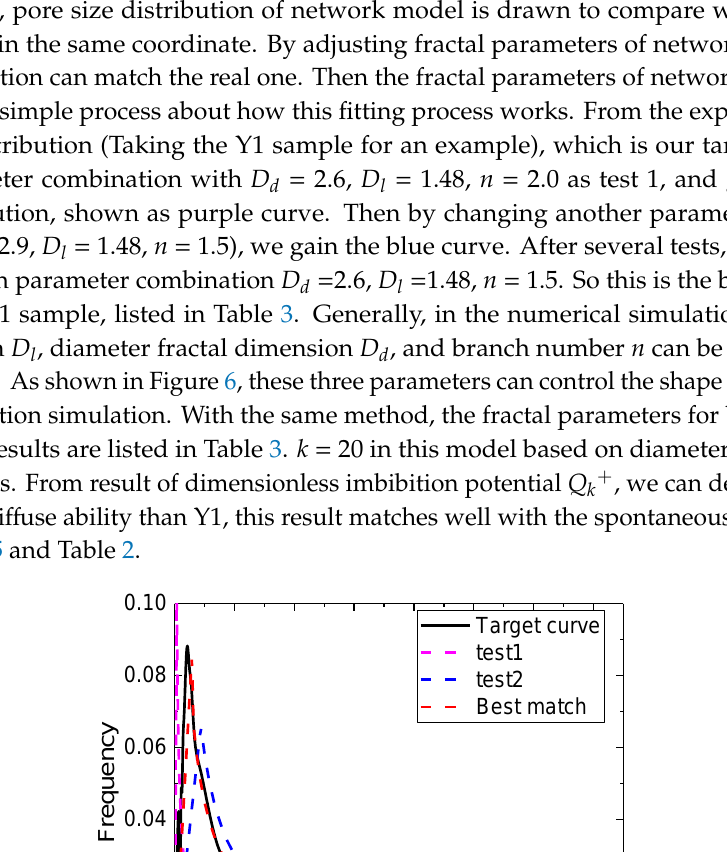
Figure 5. Pore size distribution curves derived by Nitrogen adsorption-desorption tests.